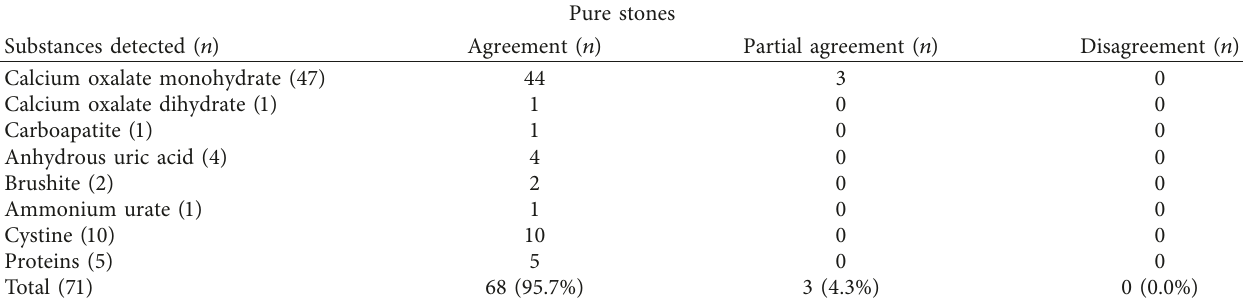
Table 2: Composition and agreement in the pure stone group. Pure